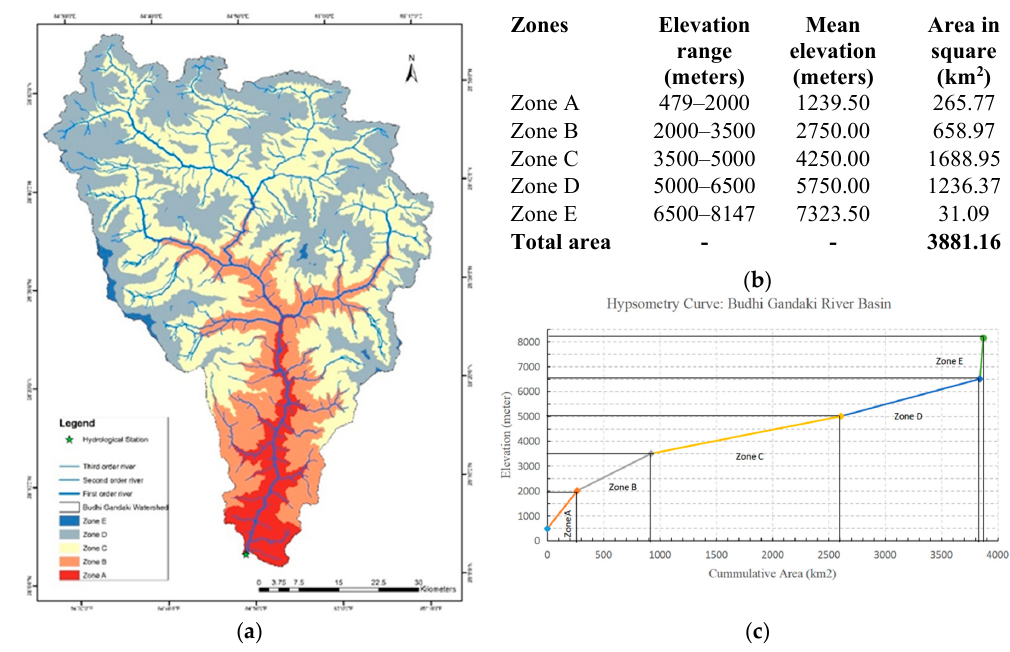
Figure 2. Zonal divisions of the basin. ( a ) Spatial division of the zones; ( b ) elevation range, mean elevation, and areas; ( c ) the hypsometry curve of the study area.